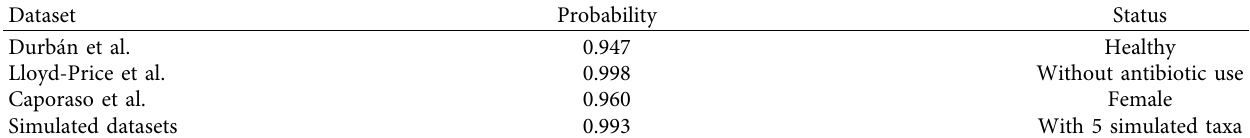
Table 3: MITRE exploratory analysis on the real and simulated datasets considered. The probabilities are associated with host status. Dataset